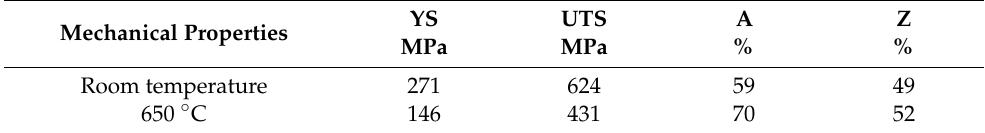
Figure 2. Dimensions in millimeters of a HR6W sample for low-cycle fatigue testing. Mechanical properties were tested at room temperature and at 650 °C. The test results are presented in Table 1. Table 1. Mechanical properties of the HR6W alloy obtained at room temperature and 650 ◦